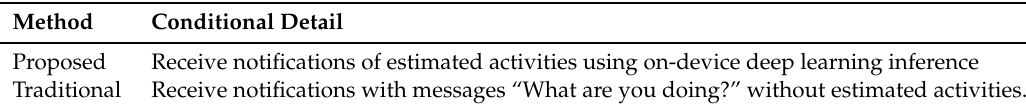
Table 1. Experimental